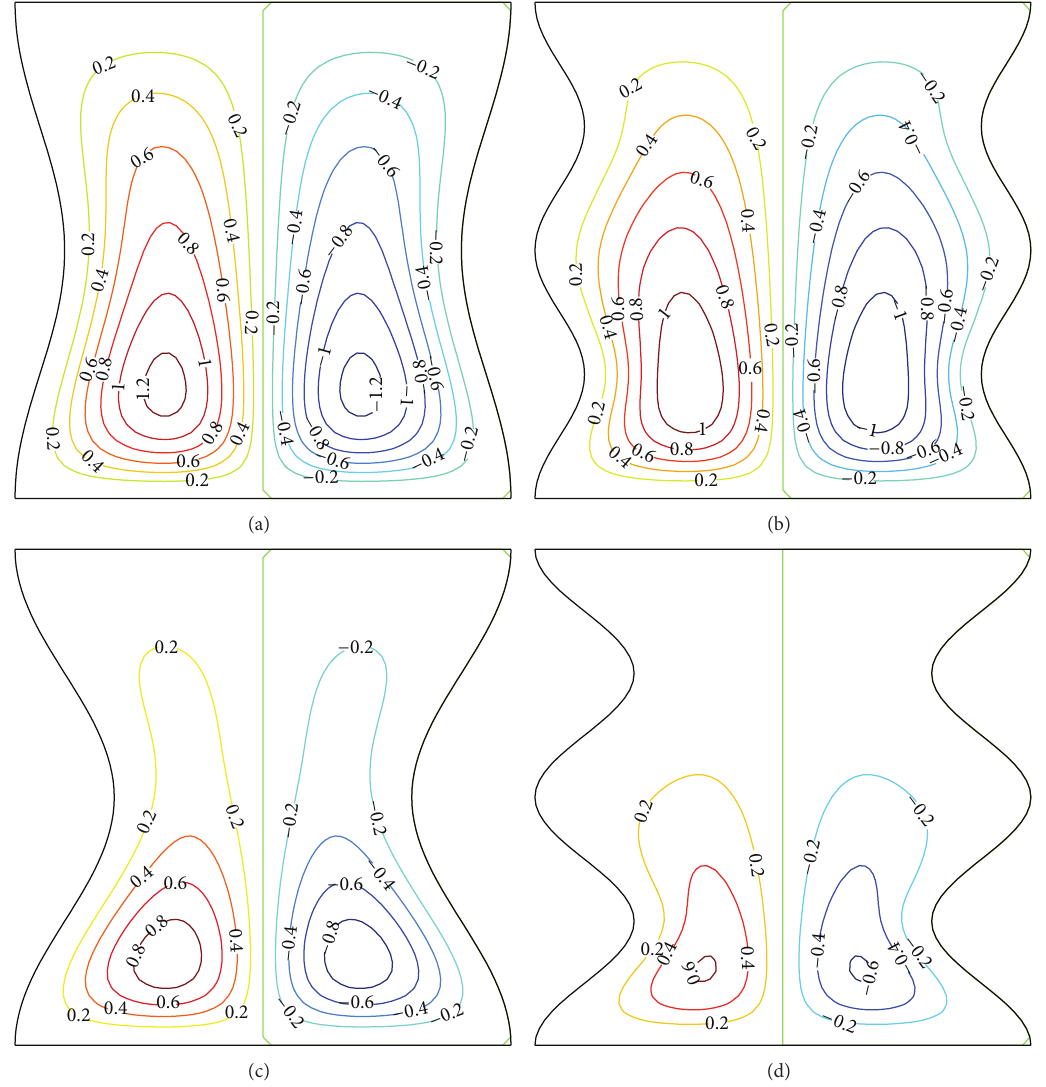
Figure 2: Streamlines ( 𝜓 ) for (a) 𝑛 = 1 , 𝜆 = 0.05 , (b) 𝑛 = 2 , 𝜆 = 0.05 , (c) 𝑛 = 1 , 𝜆 = 0.1 and (d) 𝑛 = 2 , 𝜆 = 0.1 .